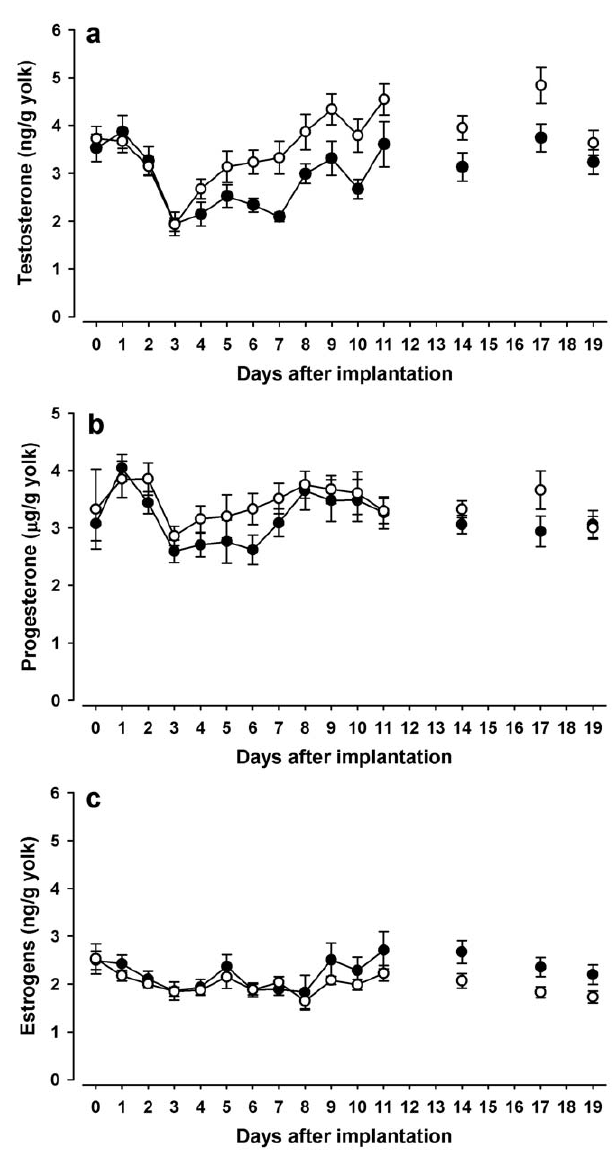
Figure 4. Hormone concentrations in yolk after pellet implan- tation. Mean ( 6 SE) concentrations of testosterone (a), progesterone N (b) and estrogens (c) in yolks from hens implanted with with ) or placebo ( # ) pellets. Eggs from days 12, 13, 15, corticosterone ( 16 and 18 were incubated to hatch chicks. Note that progesterone concentrations are a thousand-fold higher than the other two steroid hormones.